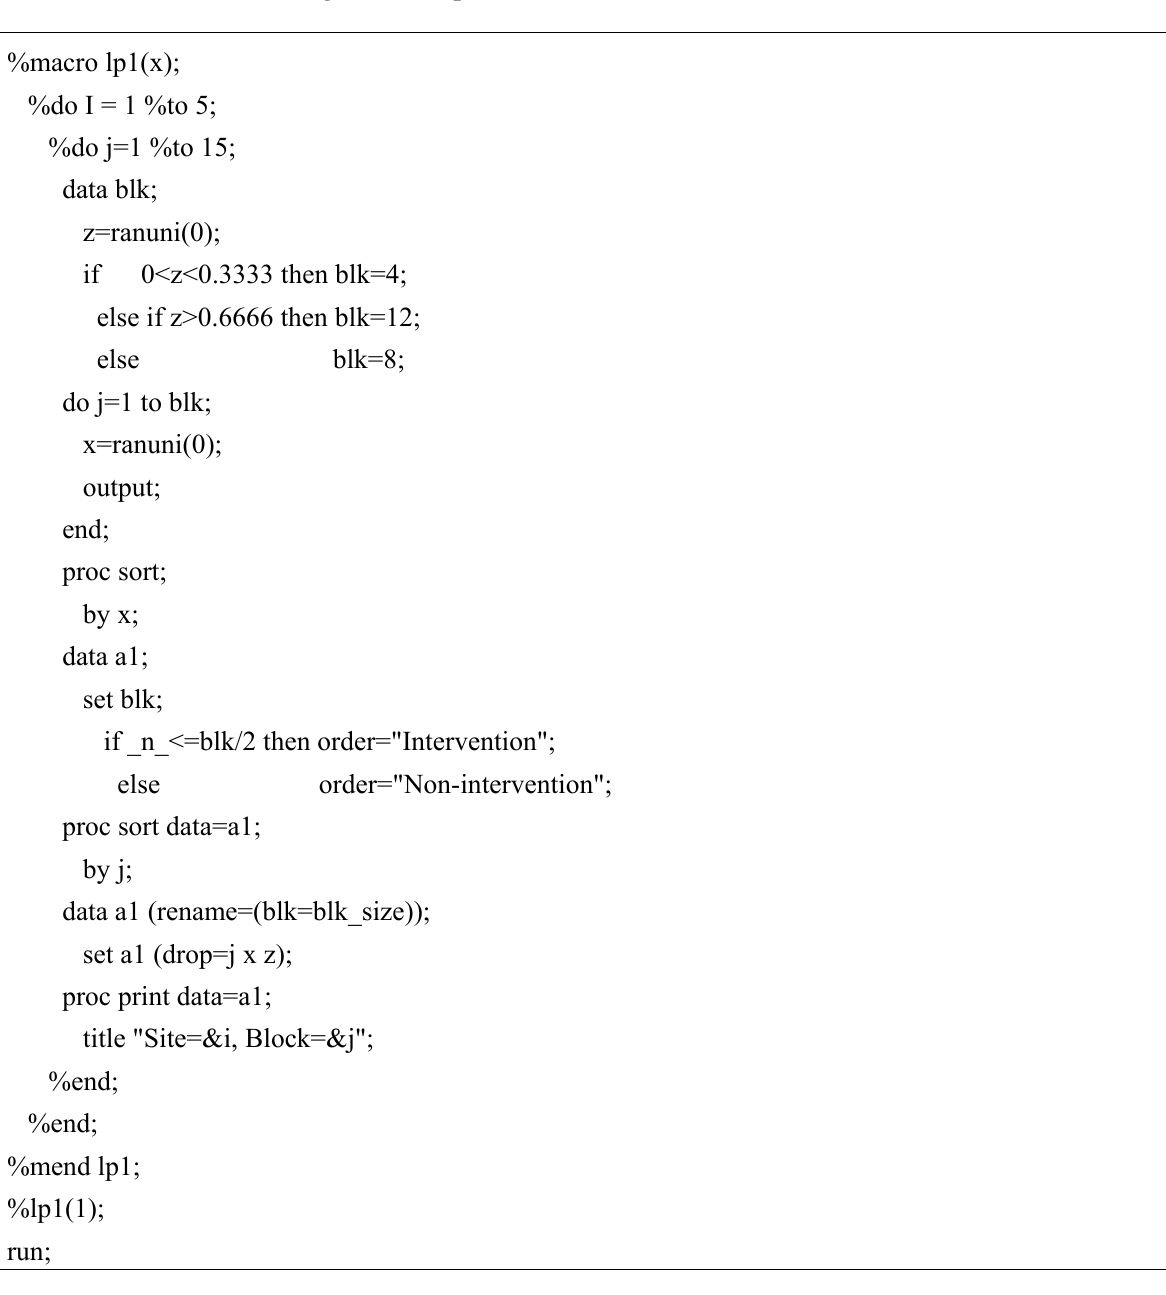
Figure 1. SAS algorithm to perform blocked randomization with random block